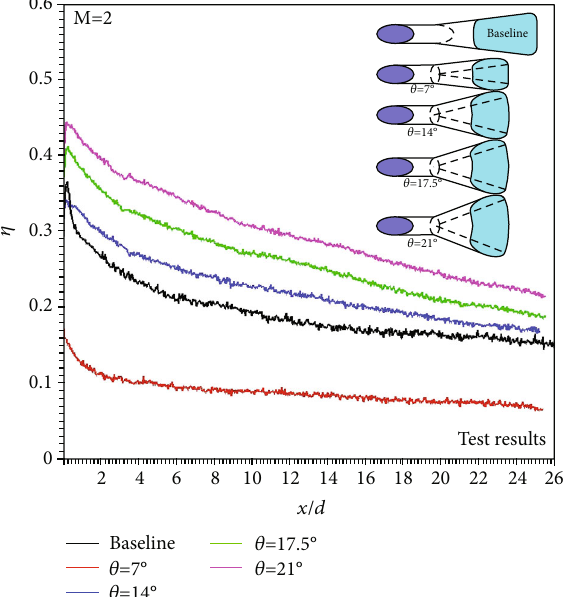
Figure 22: Streamwise variation of measured fi lm e ff ectiveness (spanwise-averaged at each point) for the blowing ratio of